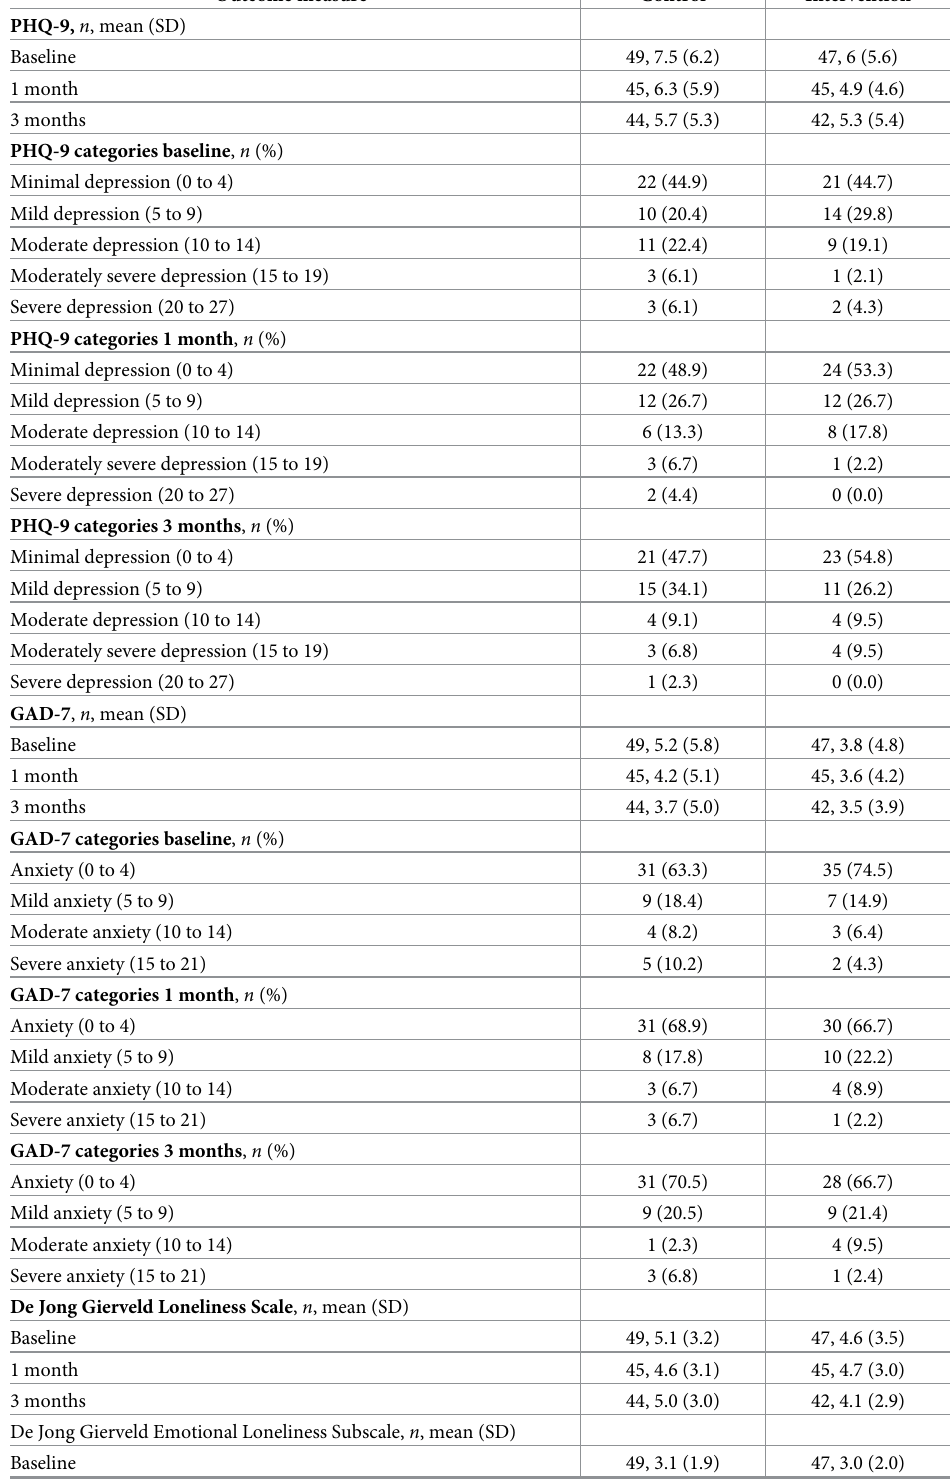
Table 2. Patient-reported outcome